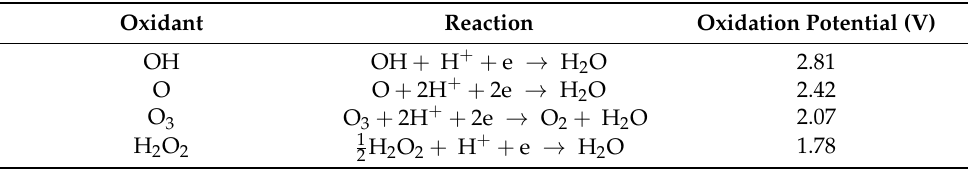
Figure 10. Three regions for a cavitation bubble [109]. Copyright 2016, with permission from Springer. Table 1. Oxidation potential of oxidants